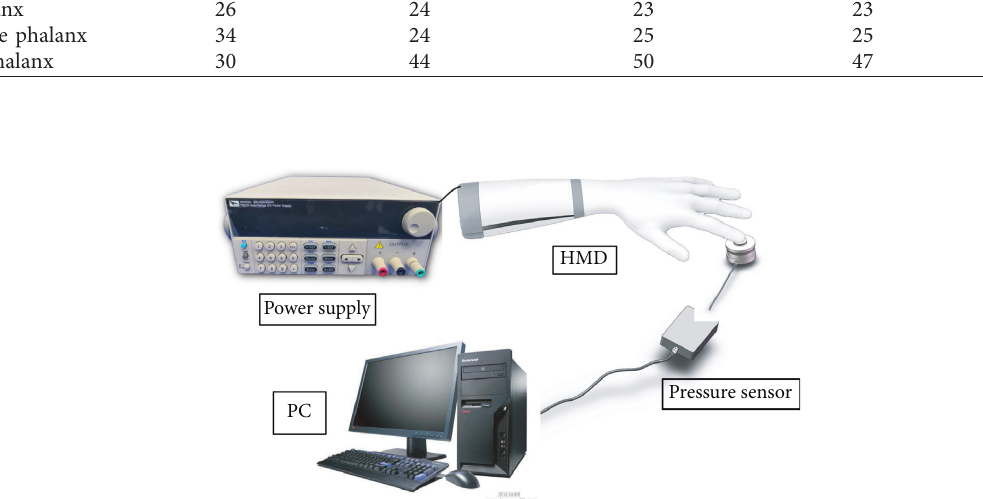
Figure 8: Experimental platform for